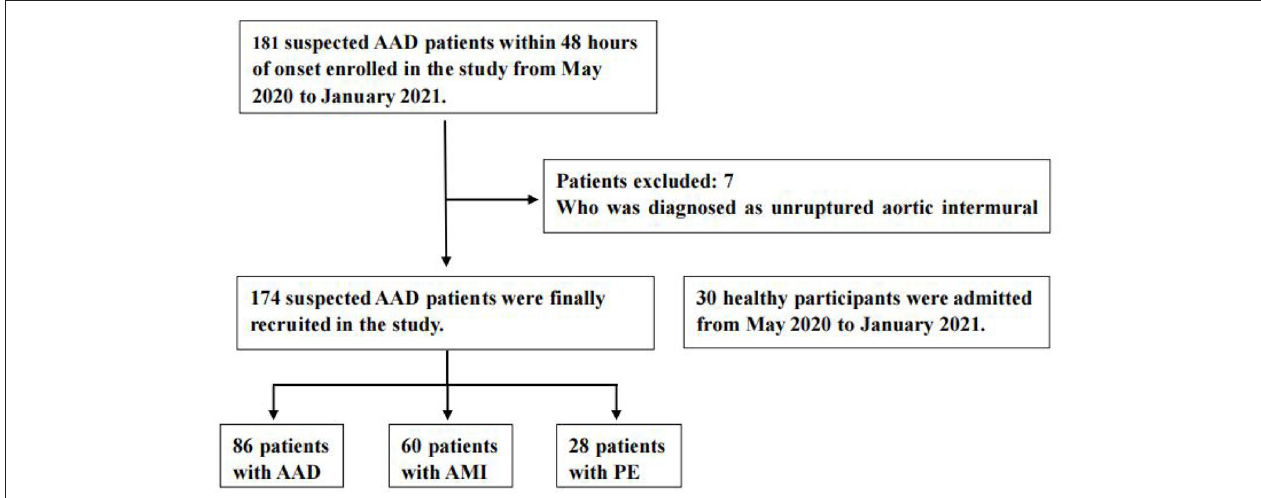
FIGURE 1 | Flow diagram of exclusion and enrollment of study patients. Describes the exclusion and enrollment of study patients. AAD, acute aortic dissection; AMI, acute myocardial infarction; PE, pulmonary